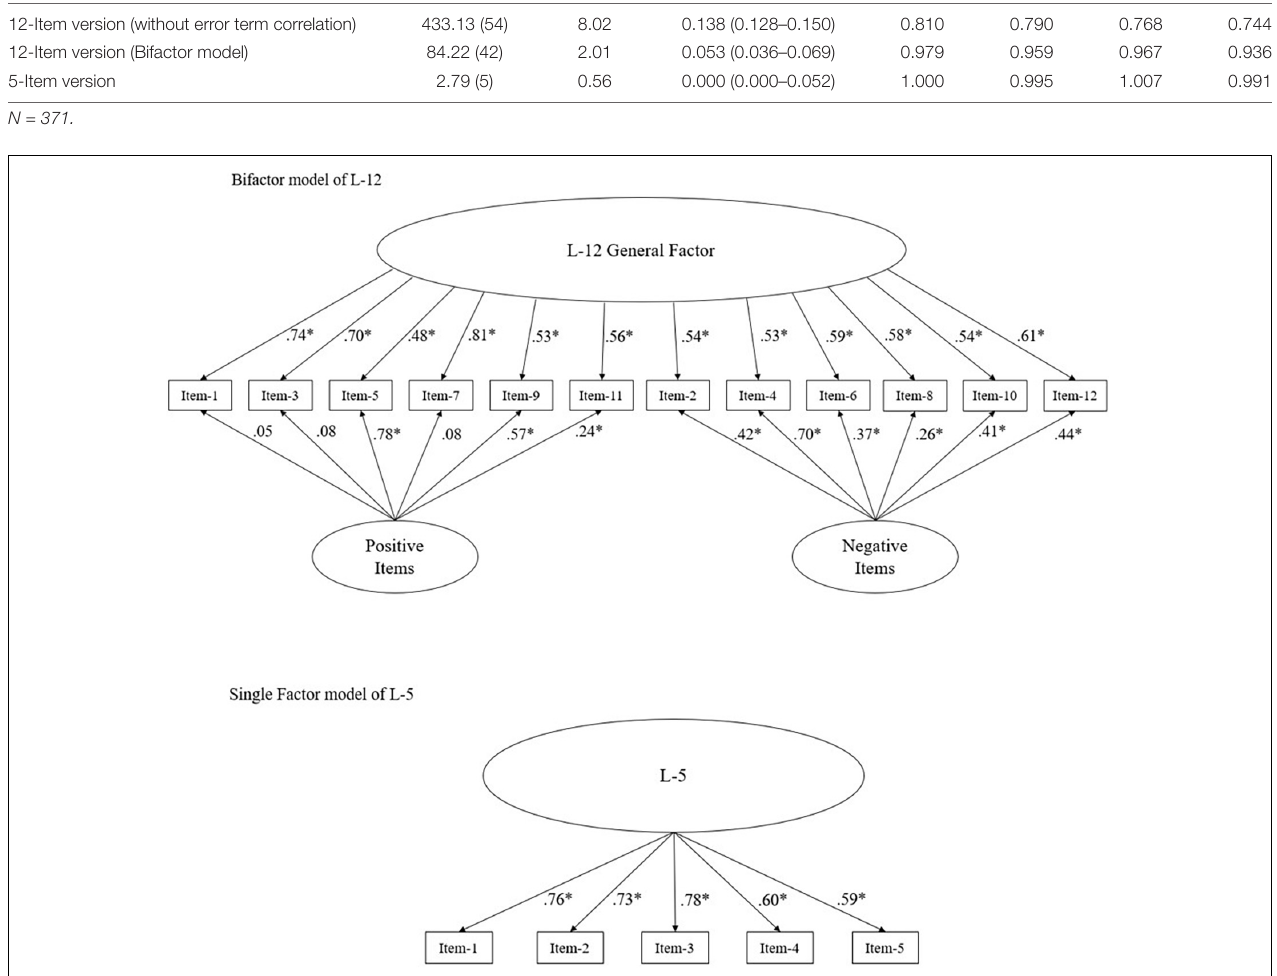
FIGURE 2 | Confirmatory factor analysis of L-12 [ χ 2 /df = 2.02; RMSEA = 0.05 (90% CI: 0.04, 0.70); CFI = 0.97; NFI = 0.96; TLI = 0.97; RFI = 0.93] and L-5 [ χ 2 /df = 0.56; RMSEA = 0.00 (90% CI: 0.00, 0.05); CFI = 1.00; NFI = 1.00; TLI = 1.01; RFI = 0.99]; N = 371; Items with even numbers are scored inversely. ∗ p <